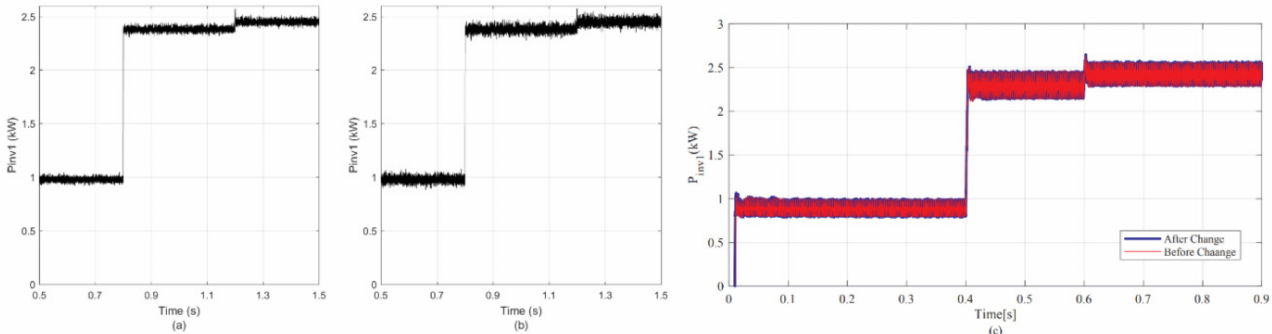
Figure 14. Active power of inter-linking inverter (inv1) under two different sets of MG parameters, ( a ) under first set, ( b ) under the second set, ( c ) under two different sets of MG parameters in reference